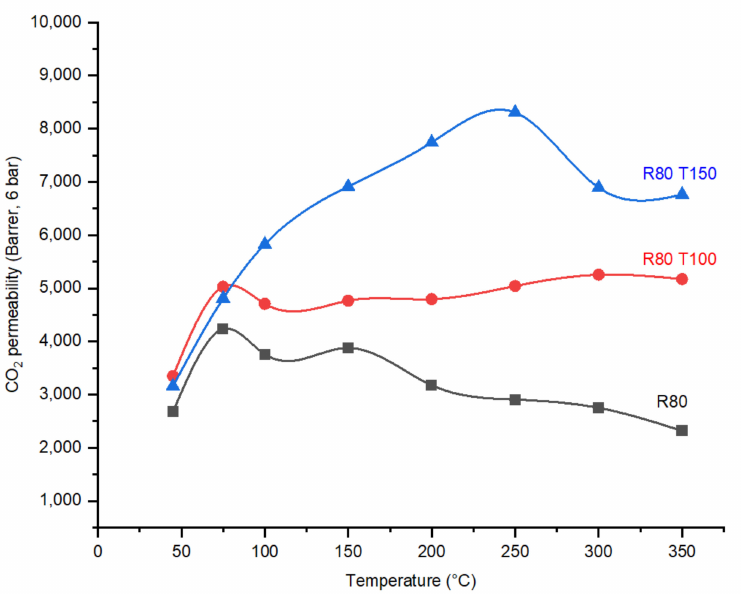
Figure 11. The effect of post treatment with oxygen on the CO 2 permeabilities of CMSMs (Carbon Molecular Sieve Membranes) as a function of